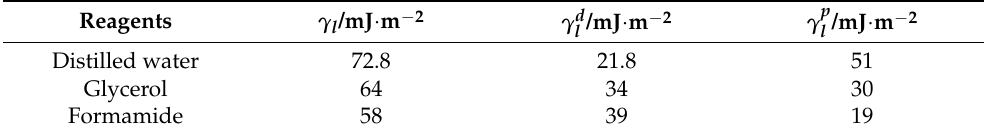
Table 5. Contents of SP and SCESP in modified